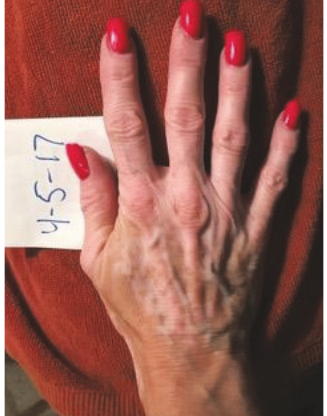
Figure 3: Clinical appearance of the right dorsal hand 13 months after using apremilast 30 mg twice